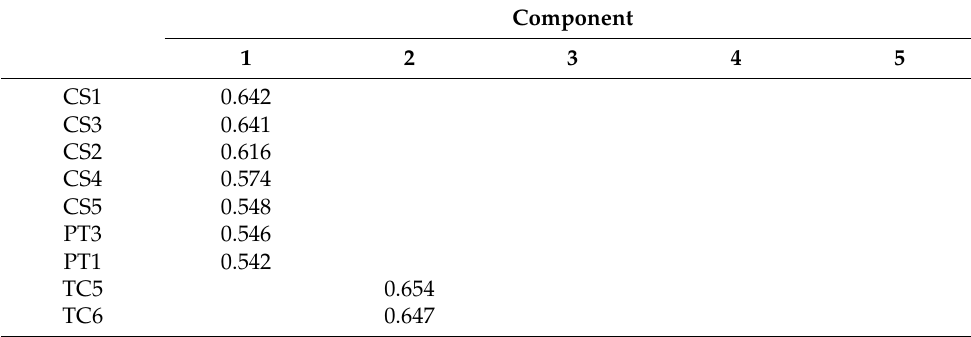
Table 5. Rotated component